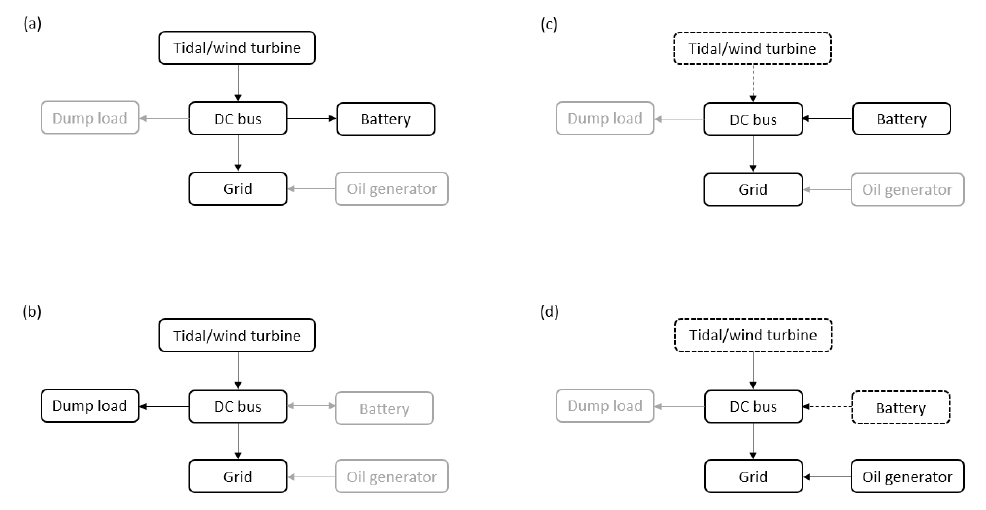
Figure 3. Illustration of the hybrid system operating